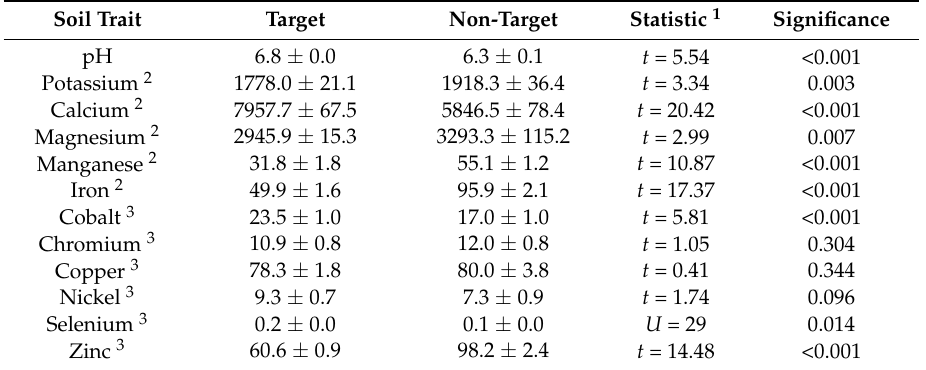
Table 2. The influence of proximity to Cycas micronesica trees on soil chemical traits in Akina soils on Guam. Target soils were collected underneath cycad trees. Non-target soils were collected 5-m from focal cycad trees. Means ± SE, n = 12.